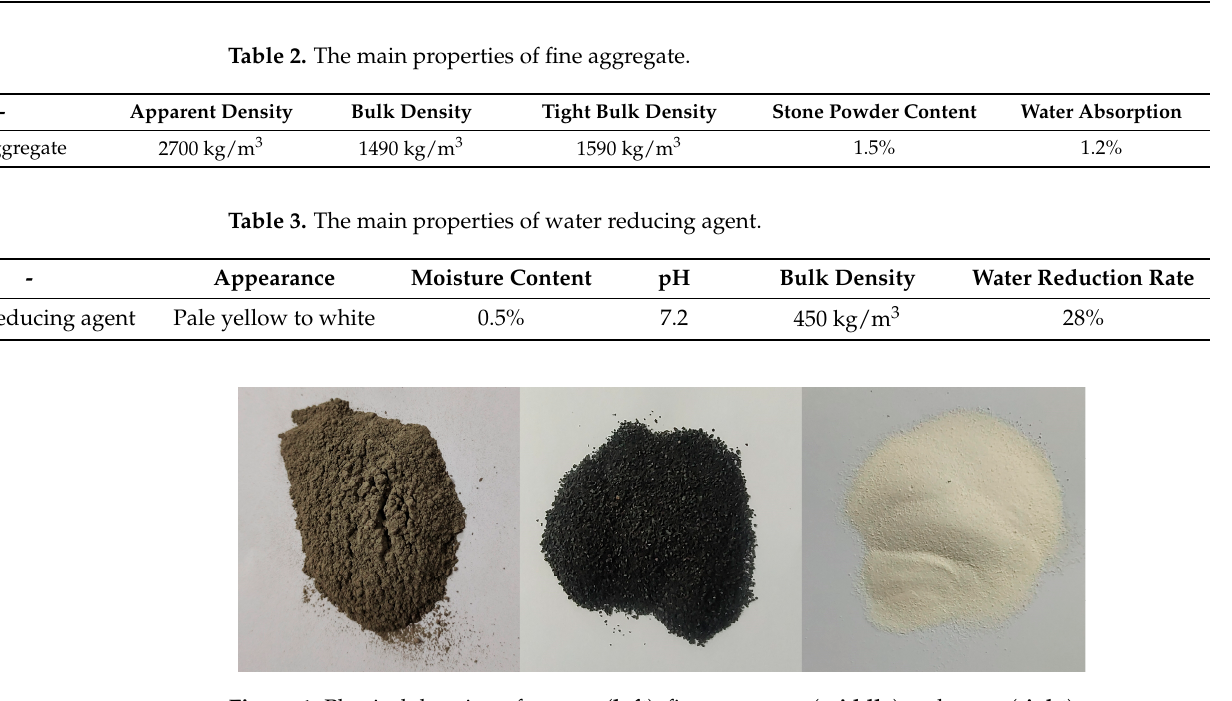
Figure 1. Physical drawing of cement ( left ), fine aggregate ( middle ) and agent ( right ).